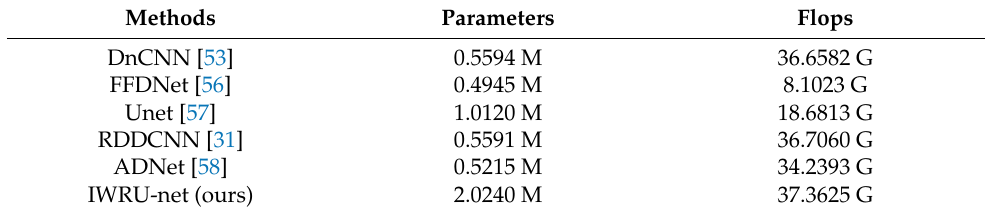
Table 5. The complexity of different watermark removal